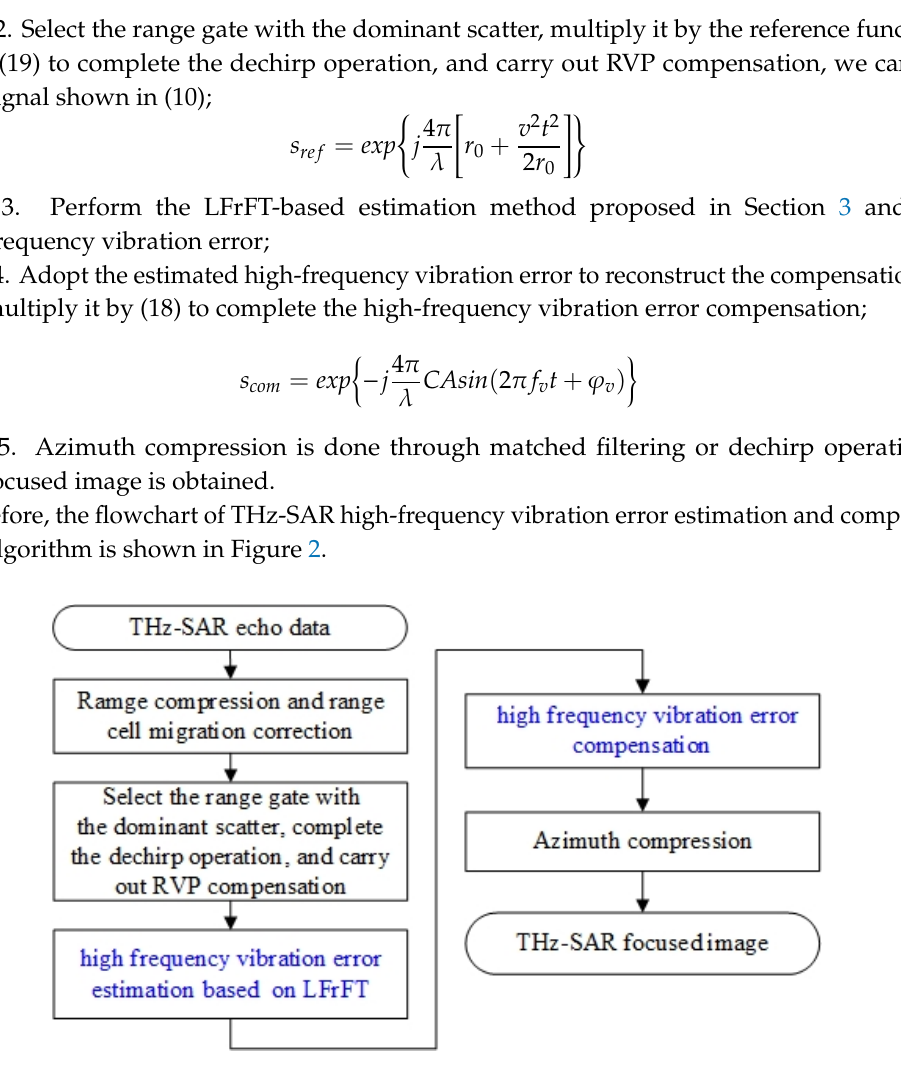
Figure 2. THz-SAR high-frequency vibration compensation imaging algorithm based on local fractional Fourier transform (LFrFT).